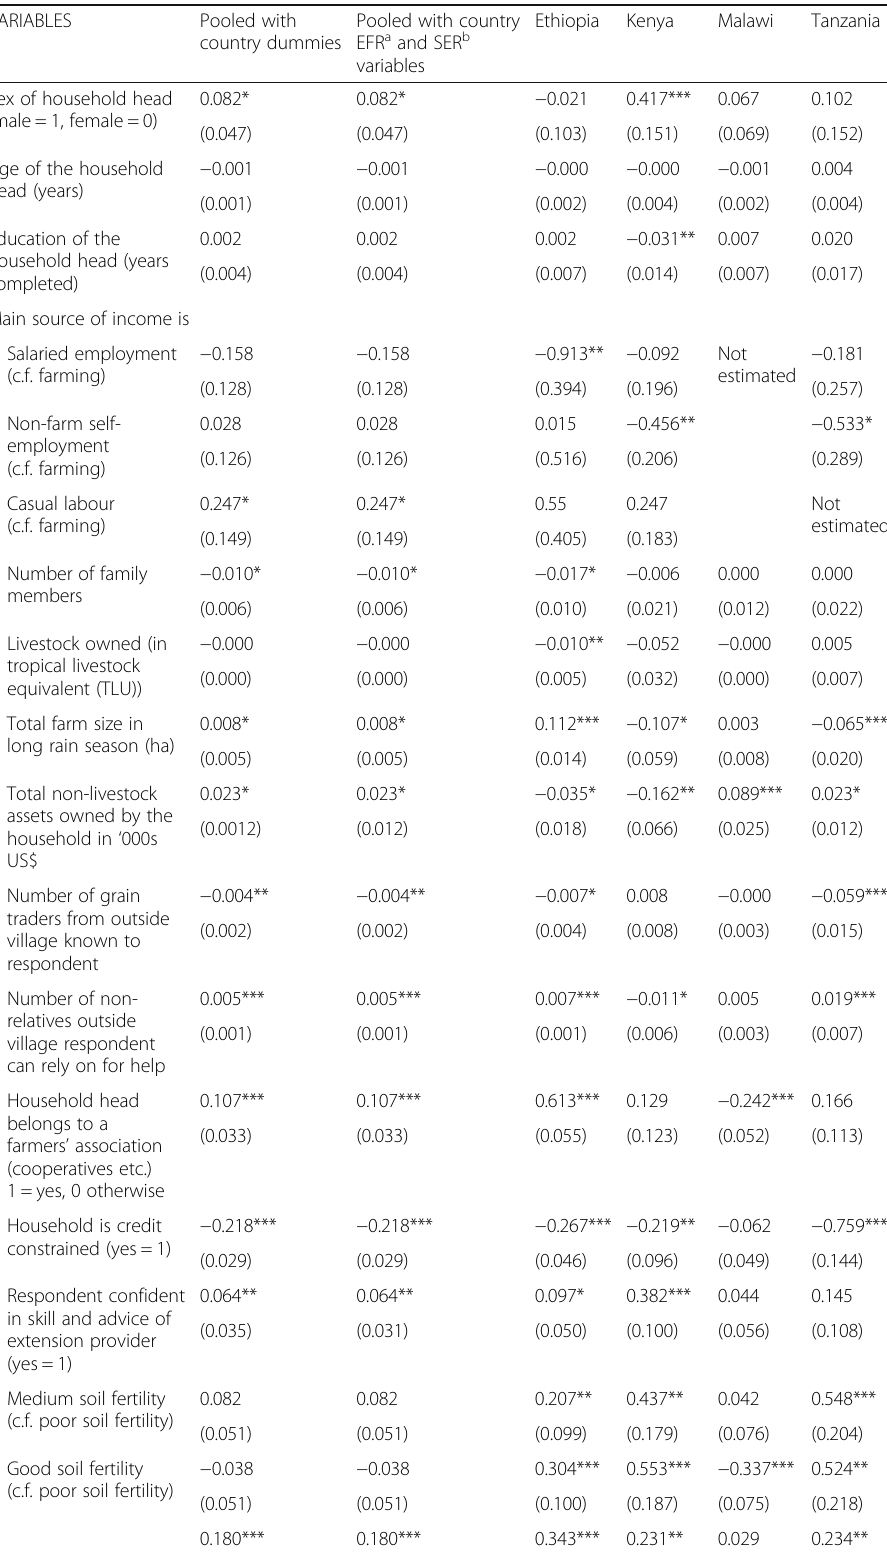
Table 3 Probit estimation of factors that affect plot level adoption of minimum tillage in Ethiopia, Kenya, Malawi and Tanzania Ethiopia Kenya VARIABLES Pooled with Pooled with country country dummies EFR a and SER b variables